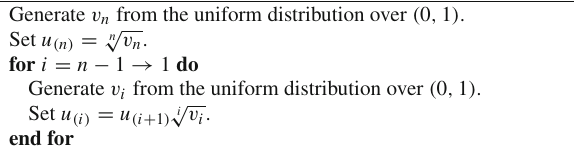
Algorithm 3 Algorithm generating a sample { u ((cid:6)) } of n ordered uniforms. The uniforms { v i } are supposed to be inde-